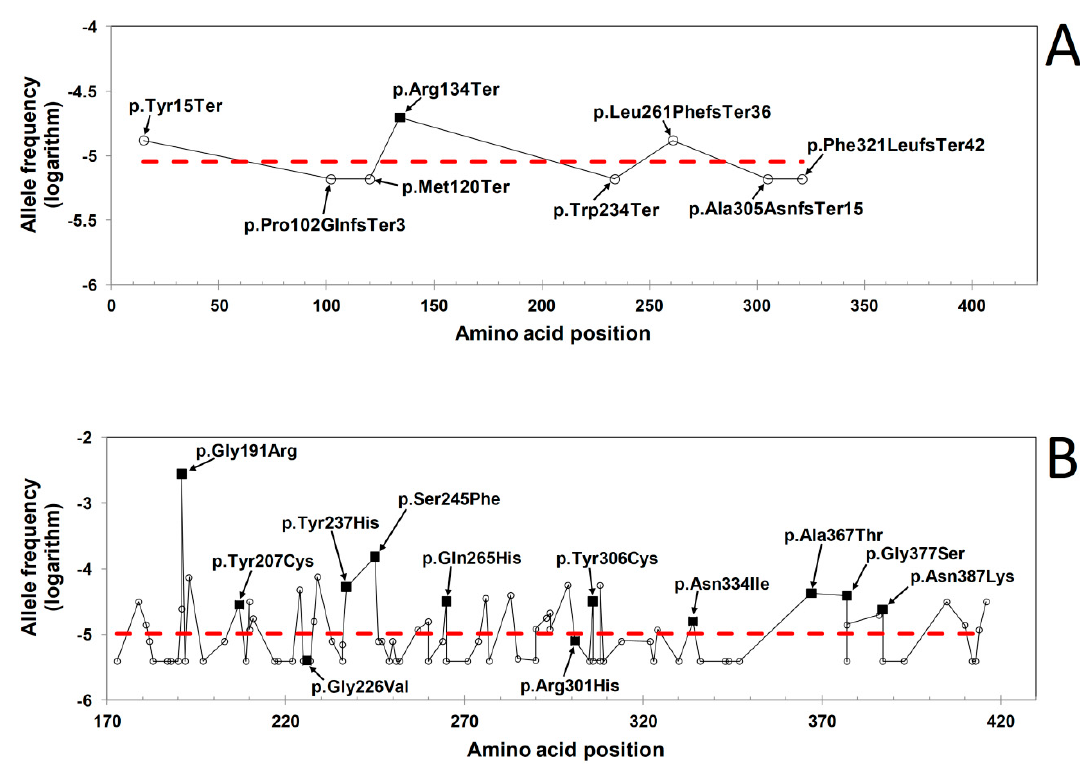
Figure 5. Allele frequency (in base-10 logarithm scale) of gnomAD variants. ( A ) Truncating and frameshift variants. ( B ) Missense variants. The variants simultaneously reported by gnomAD and HGMD are indicated by closed squares, variants reported only by gnomAD are indicated with open circles. The horizontal dashed red line represents the averaged logarithms of allele frequencies of all variants displayed in the individual graphs. As a trend, it can be noticed that in both graphs, variants simultaneously reported by gnomAD and HGMD tend to be more frequent than variants recorded exclusively in gnomAD.